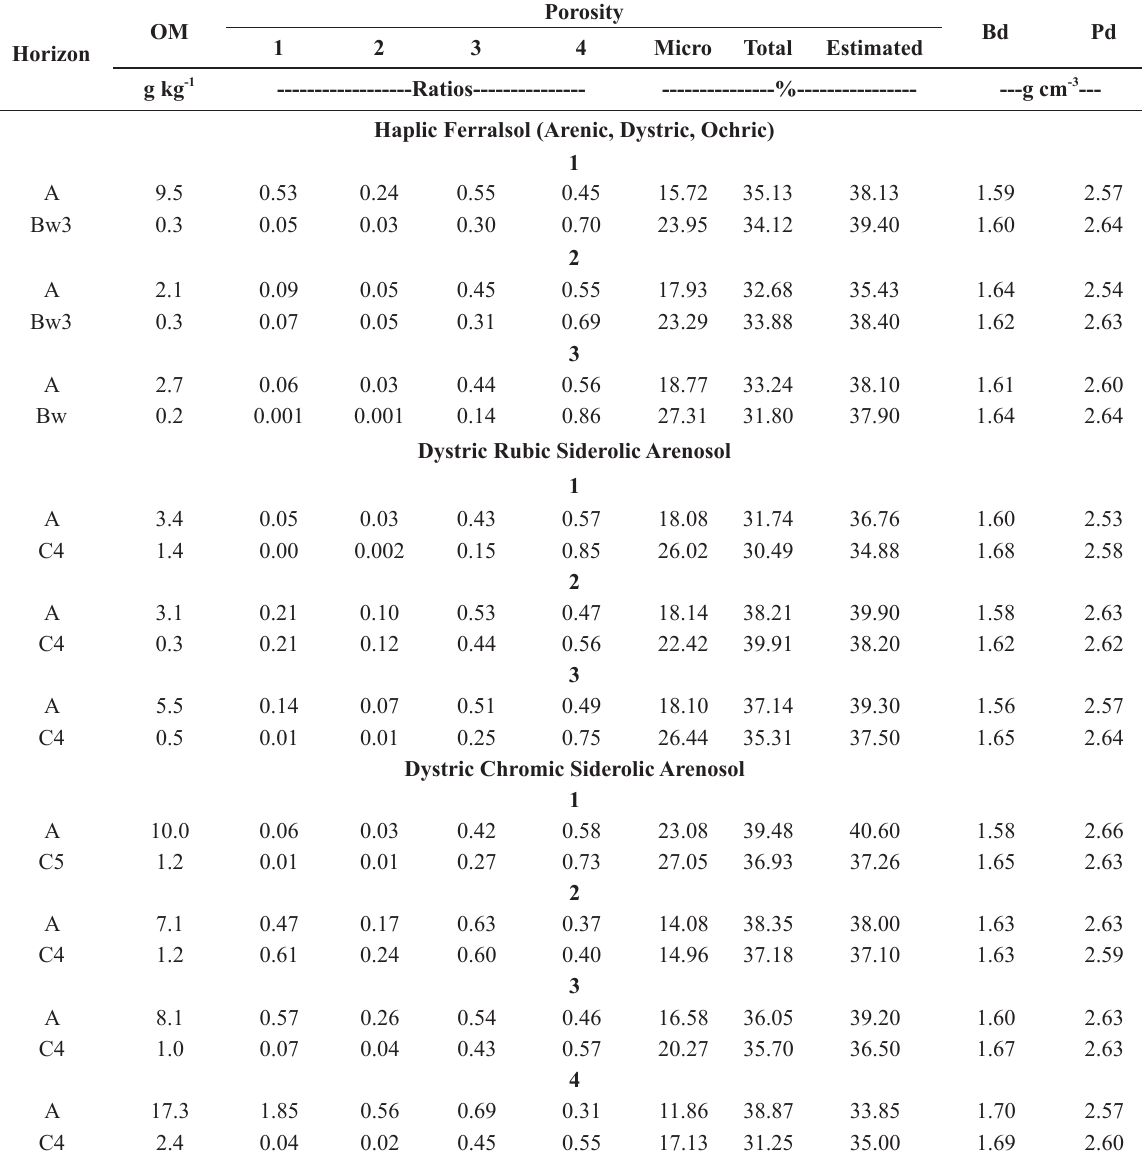
Organic matter and physical characteristics of sandy soils from the municipality of Glória, Bahia state, Brazil. OM Horizon